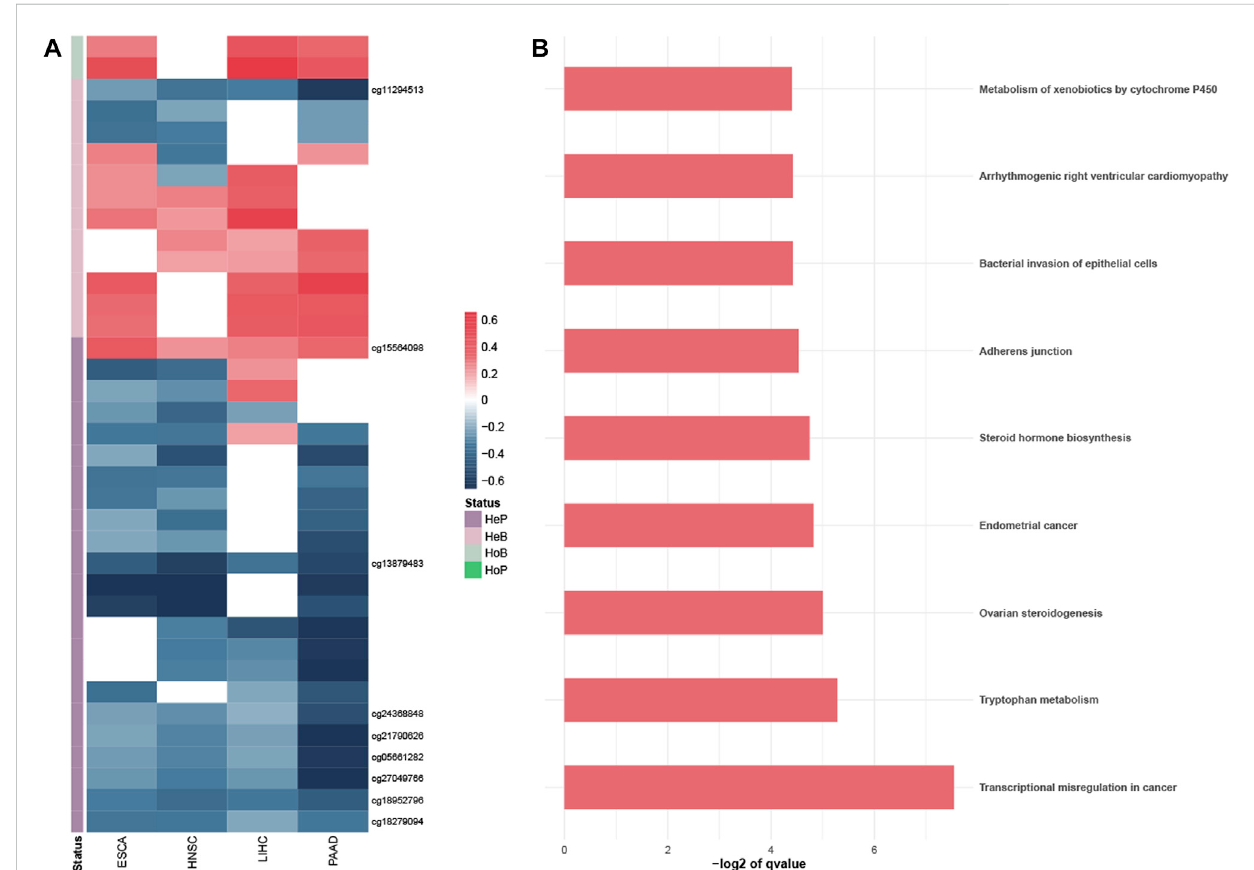
FIGURE 4 Exploration of the PDMP-annotated genes. (A) Heatmap revealed the Pearson coef fi cient correlations between PDMPs and annotated genes. PDMPs were de fi ned into four groups: HeP, hypermethylated probe in the promotor region; HeB, hypermethylated probe in the body region; HoP, hypomethylated probe in the promotor region; HoB, hypomethylated probe in the body region. (B) . KEGG enrichment analysis of 33 PDMP-annotated